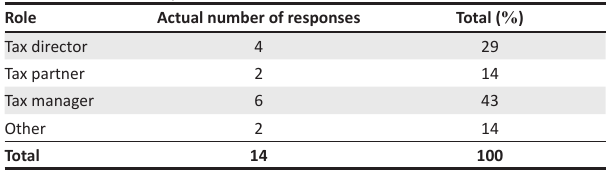
TABLE 4: Profile of